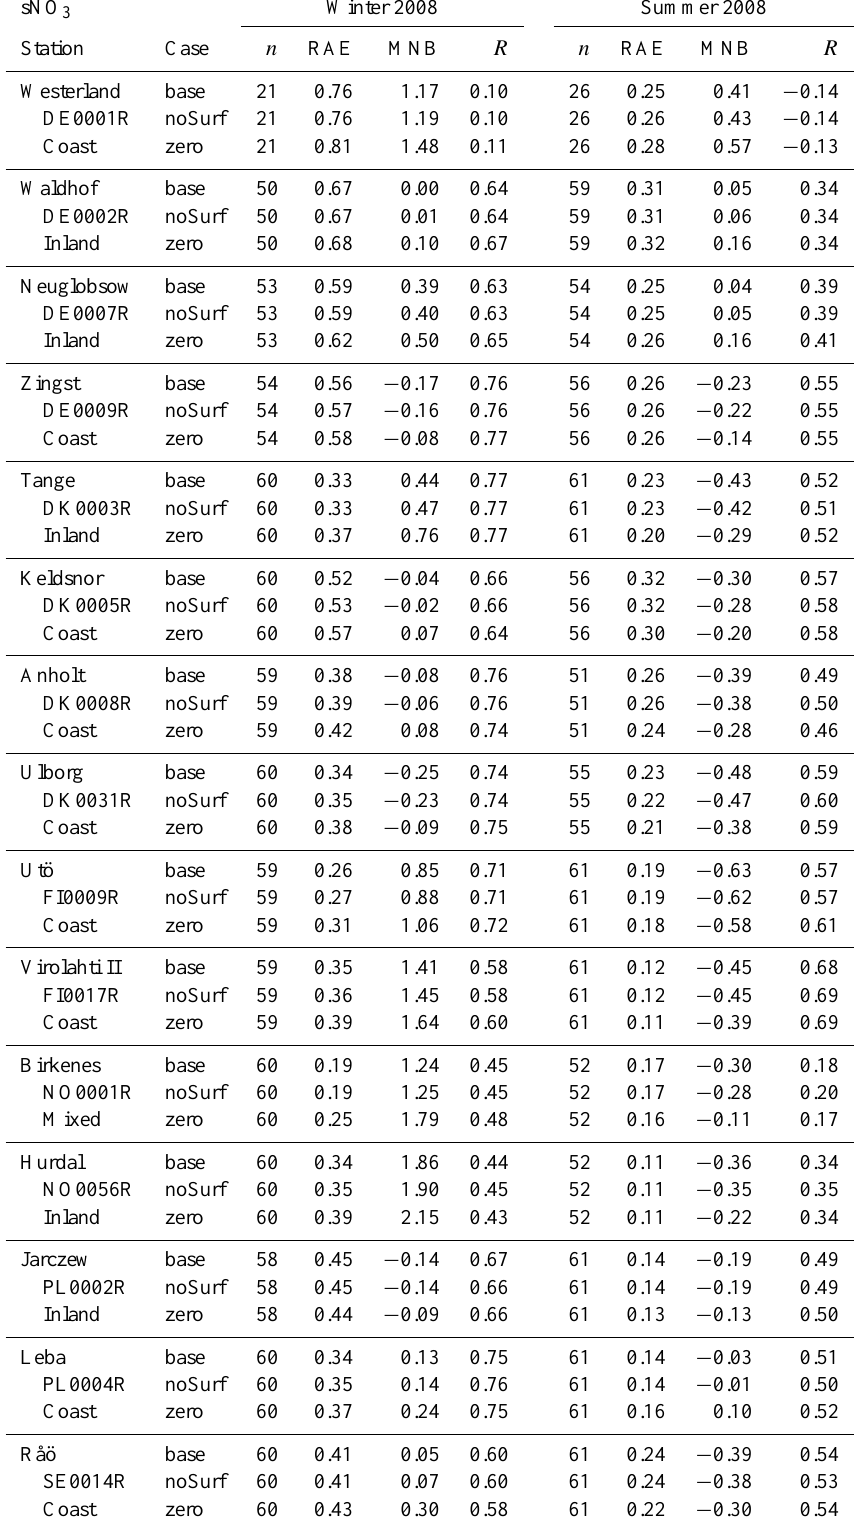
Table 4. Similar to Table 2 but showing sNO 3 (HNO 3 + NO − – are